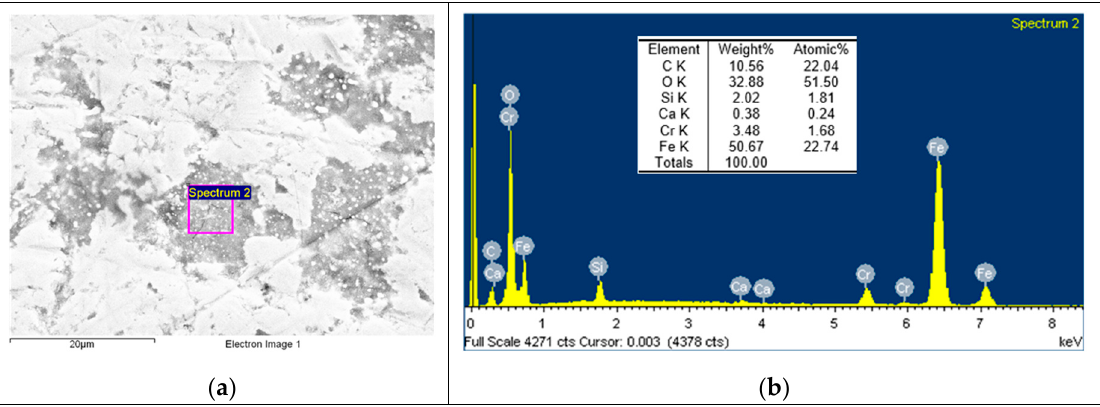
Figure 8. ( a ) SEM image and ( b ) EDS spectrum for discs tested against the PA46GT sample.